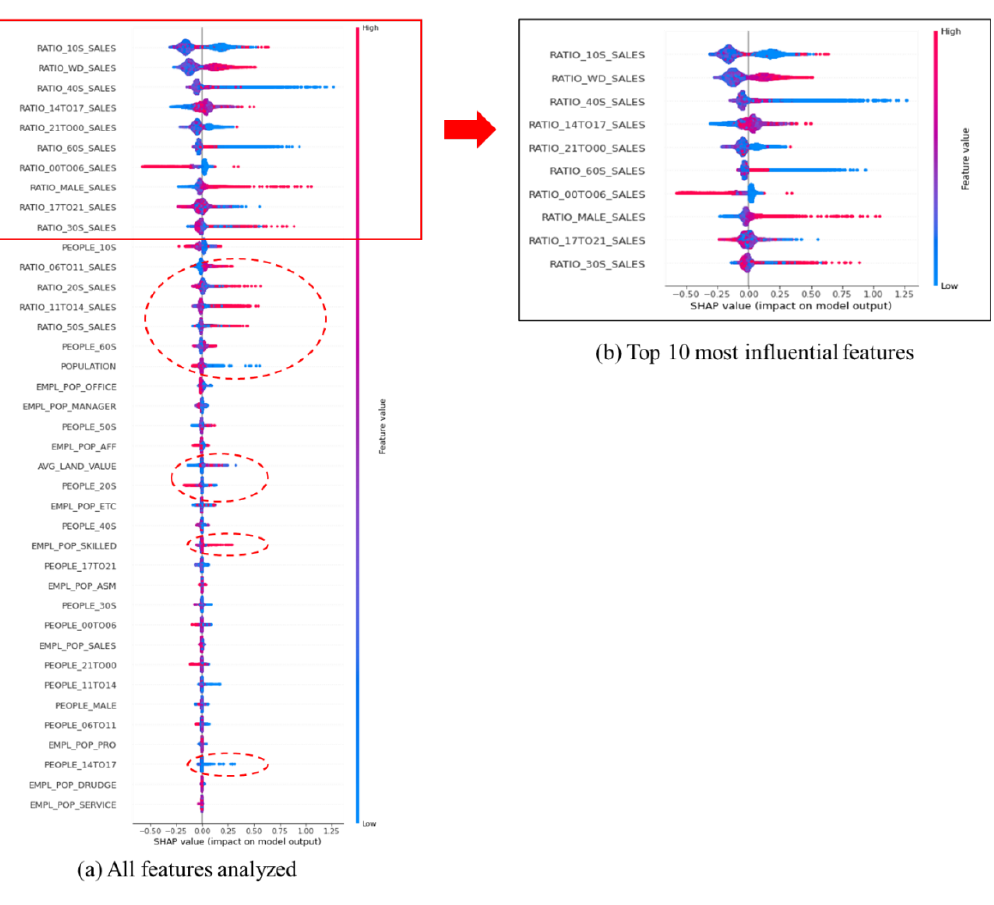
Figure 5. A summary plot for all features with the top 10 most influential